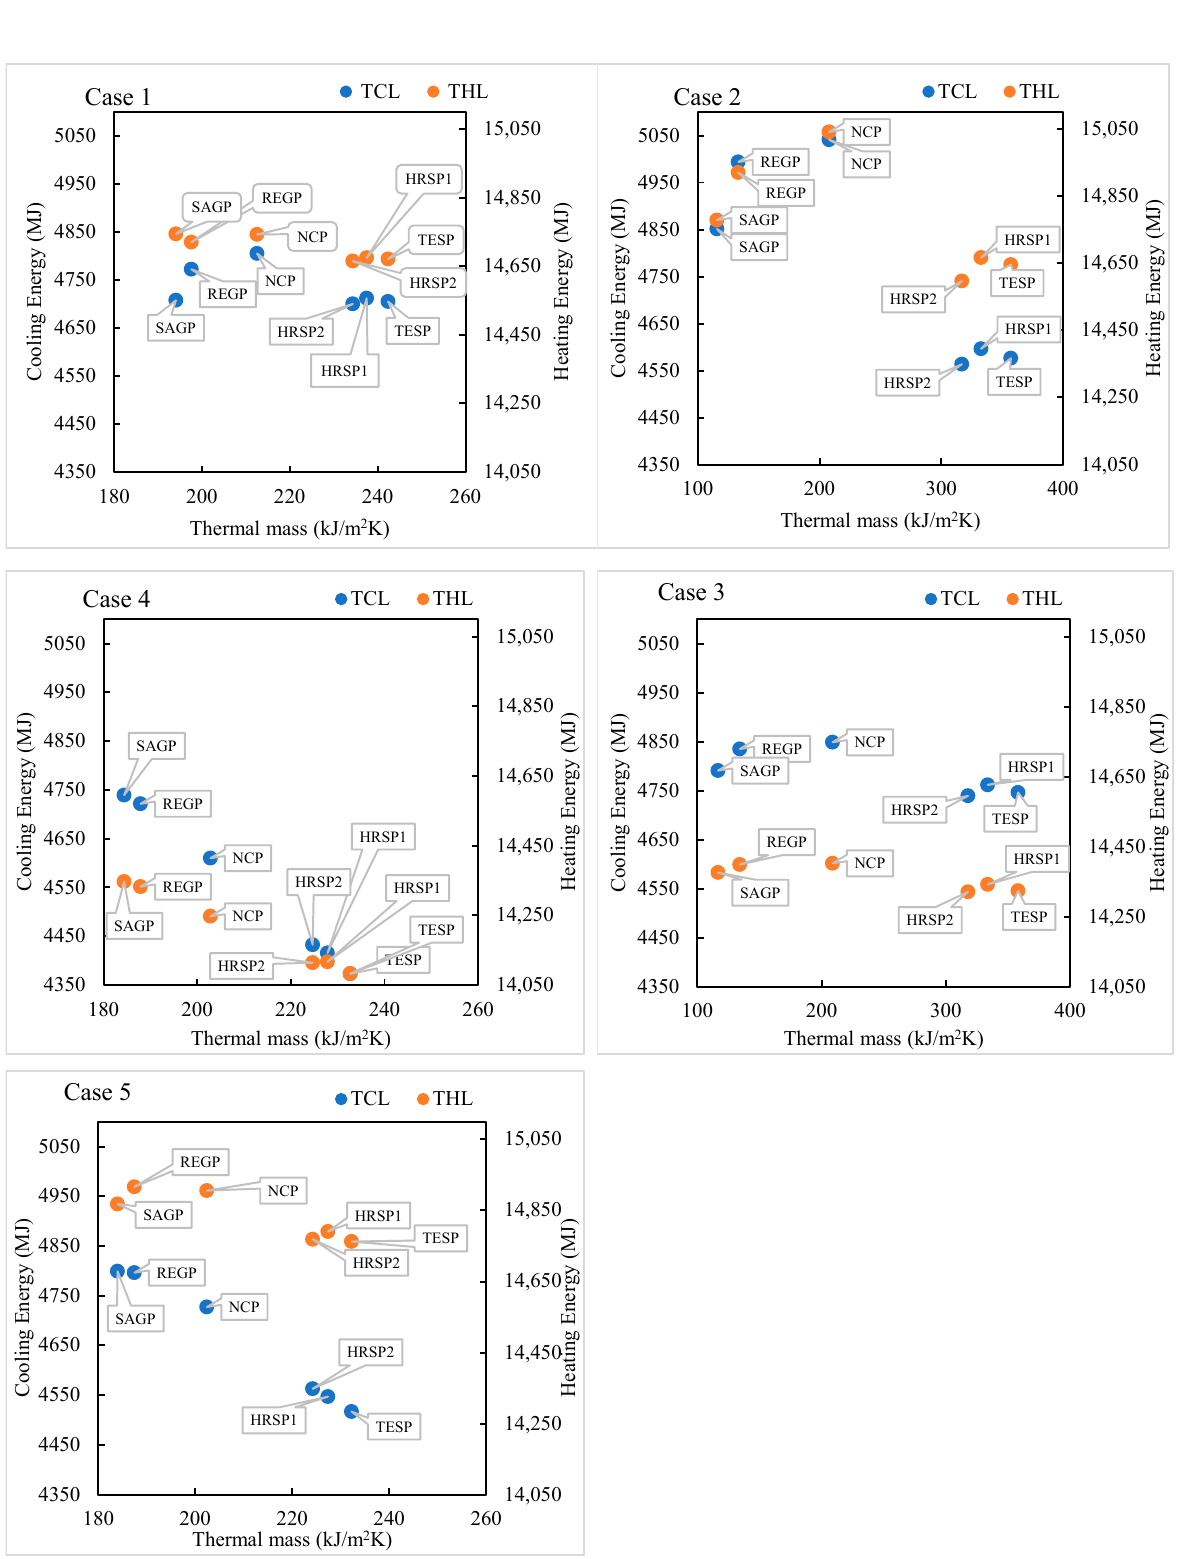
Figure 12. Effect of external wall thermal mass on (a-b) operation energy consumption (cooling and heating).